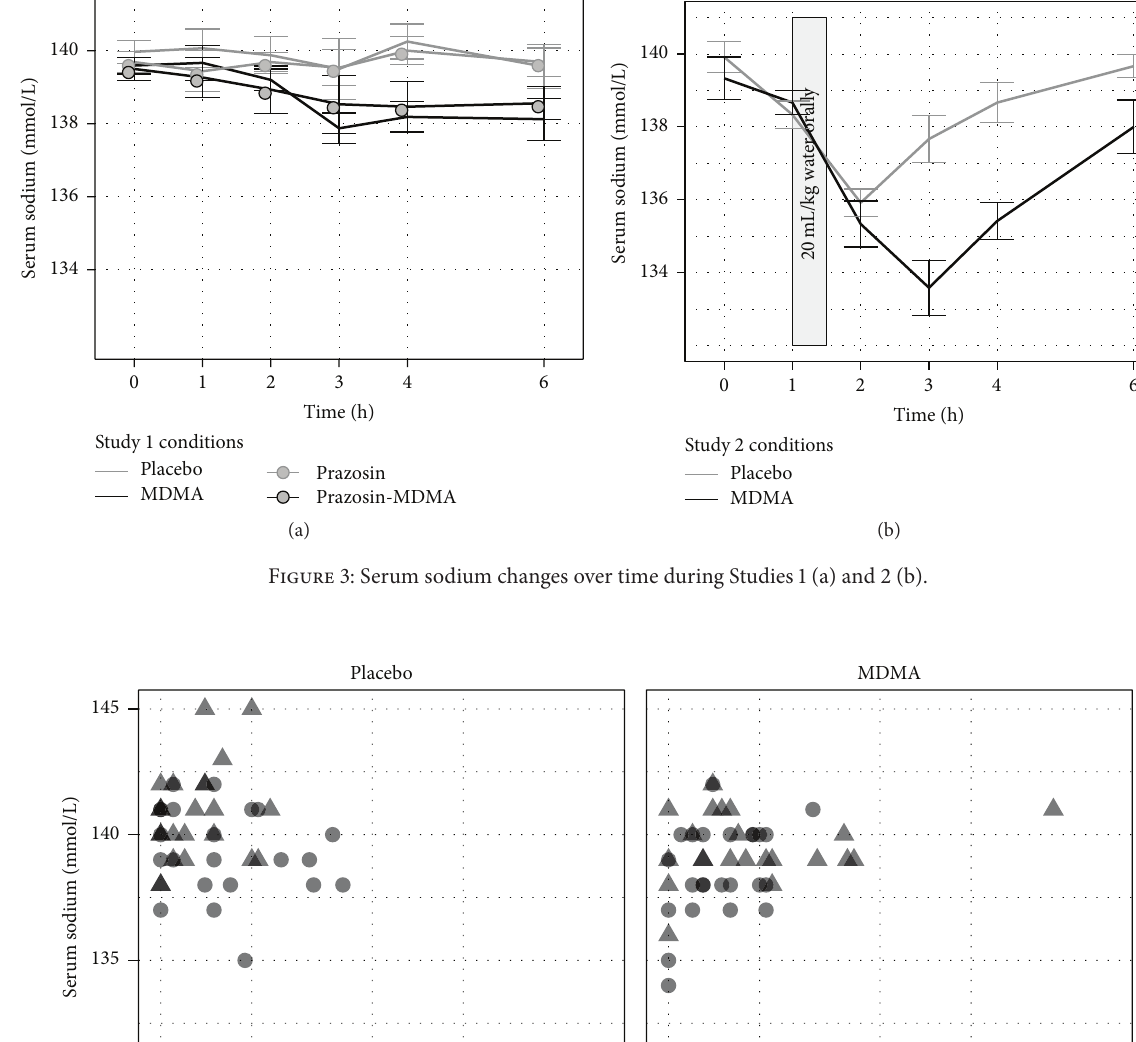
common drug effect rather than a rare idiosyncratic